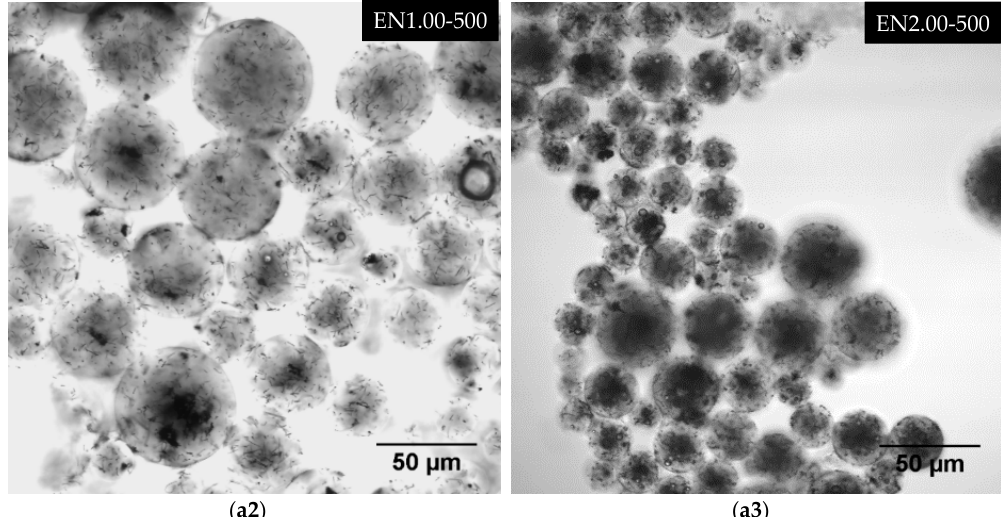
Figure 14. Laser scanning confocal microscopy (LSCM) micrographs showing CNT dispersion features observed within the microcapsules.